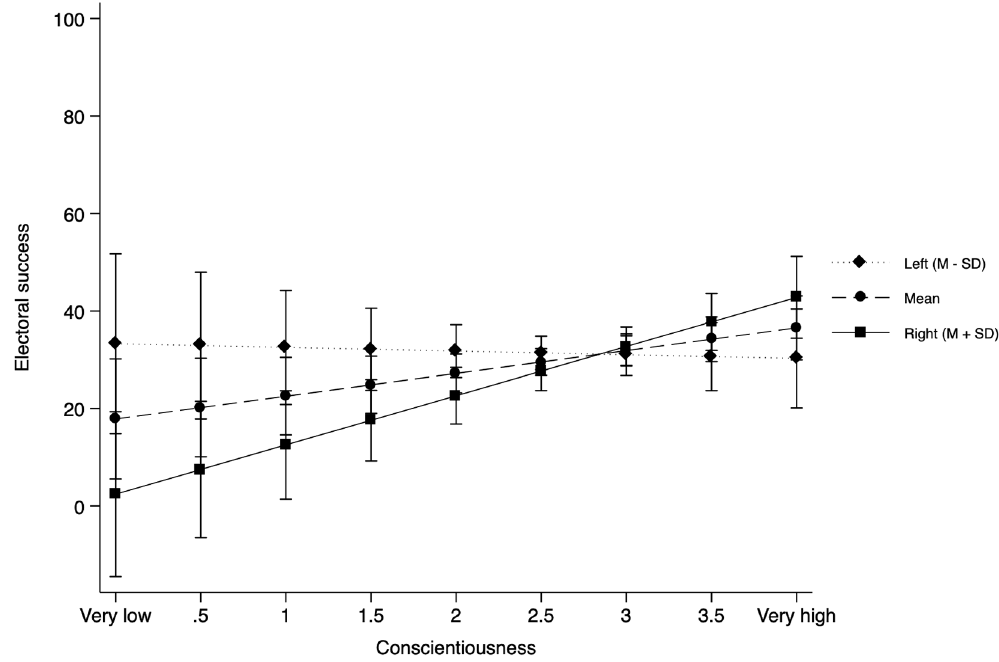
Figure 4. Electoral success by left-right * Conscientiousness; marginal effects. Note. Marginal effects with 95% CI, based on coefficients in Table 5 (model M2). All other variables fixed at their mean. The three groups represent three critical values for left-right, respectively at the mean value, one standard deviation below the mean value (left), and one standard deviation above the mean value